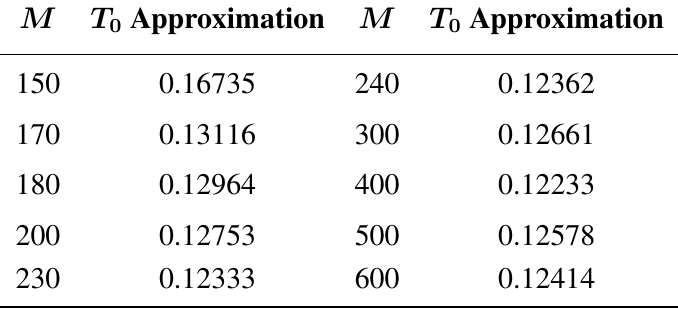
in Dawson’s integral example using extrapolations of fitted 0 = 0 . 125 , averaged value is T ( aver ) 0